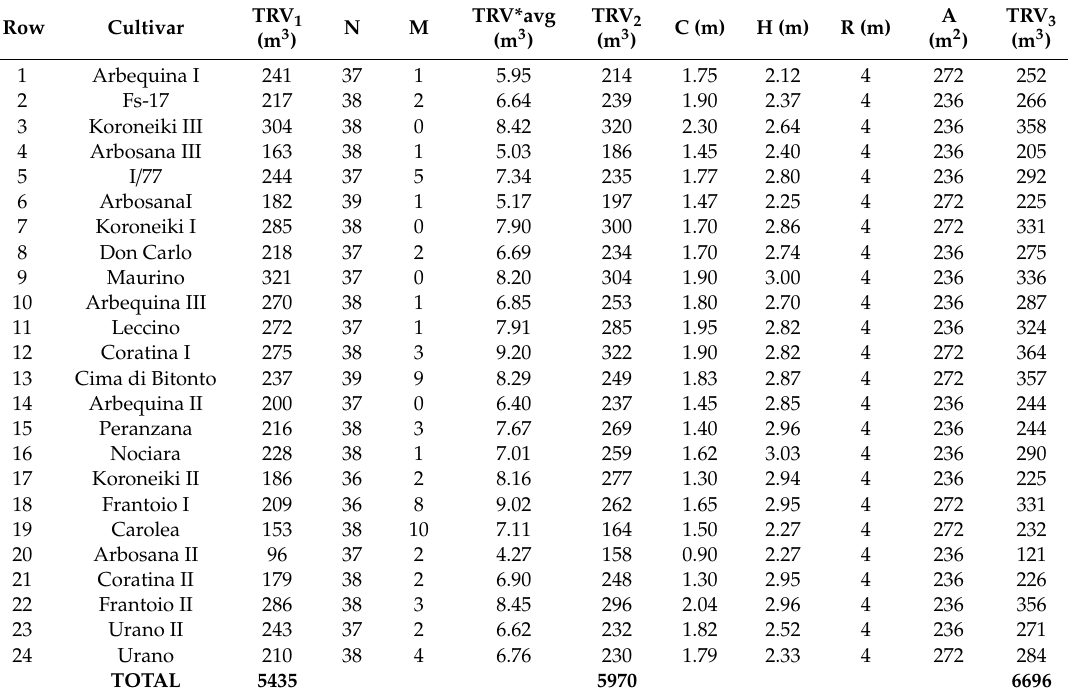
Table 1. Results of the three di ff erent methods for calculating tree row volume (TRV).